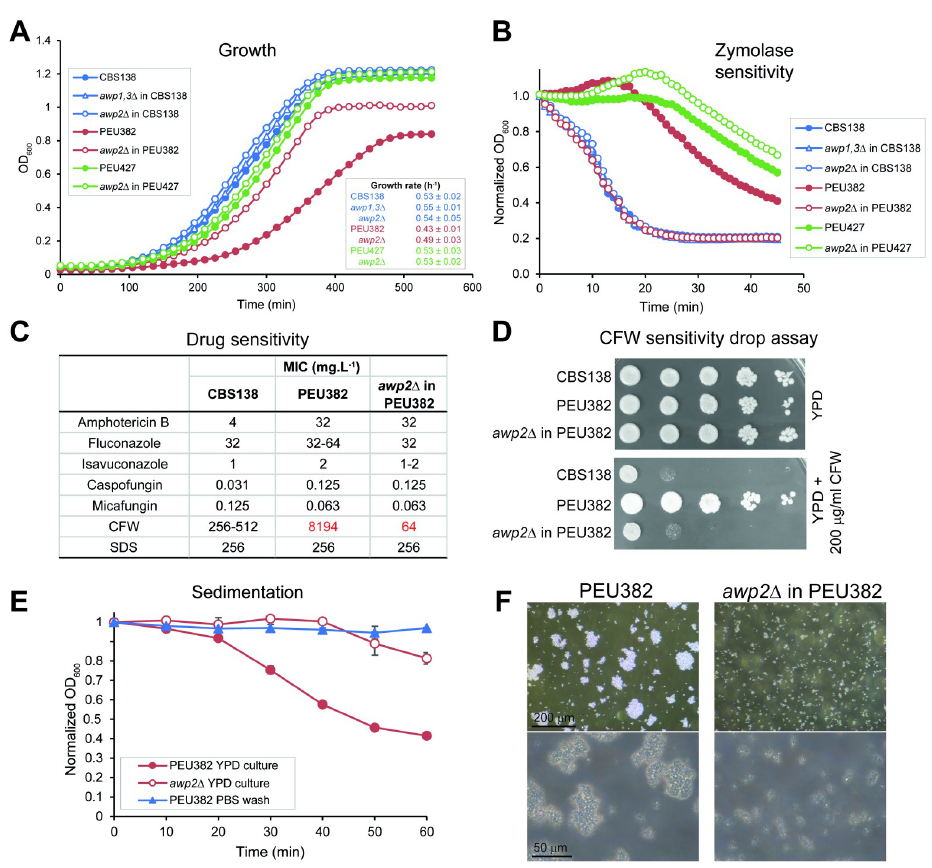
Fig 3. Deletion of AWP2 overrides cell surface-related phenotypes of hyperadhesive strain PEU382. (A) Growth rate, (B) zymolyase sensitivity, (C) drug sensitivities using microbroth dilution methods, (D) Calcofluor white drop assay, (E) sedimentation and (F) aggregation of awp mutants. For reasons of clarity (C-F) are limited to CBS138, PEU382, and awp2 Δ in PEU382.